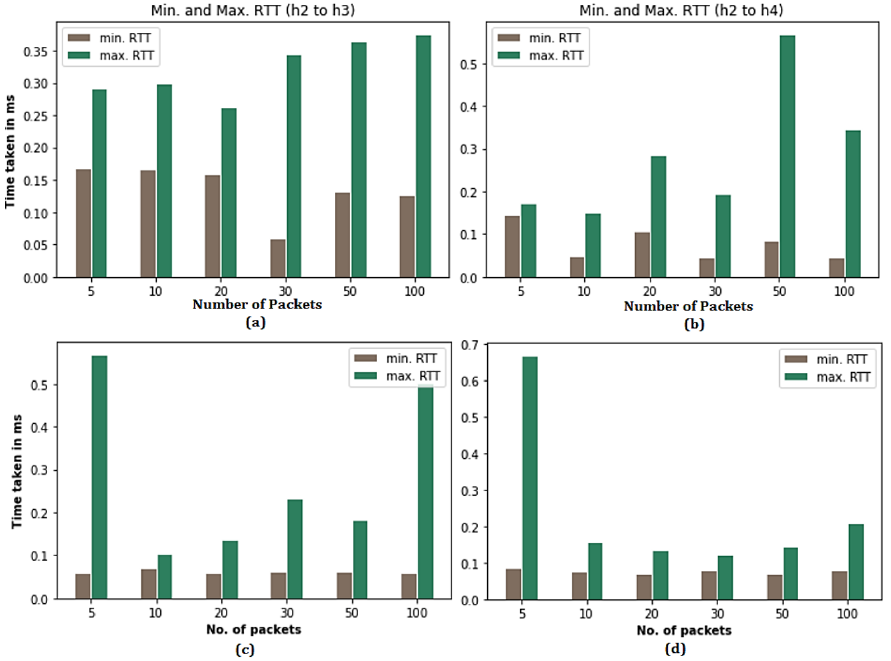
Figure 19. Min. and Max.RTT for neighbouring AS for host h2, ( a , b ) for Host h1 in legacy, and ( c , d ) in